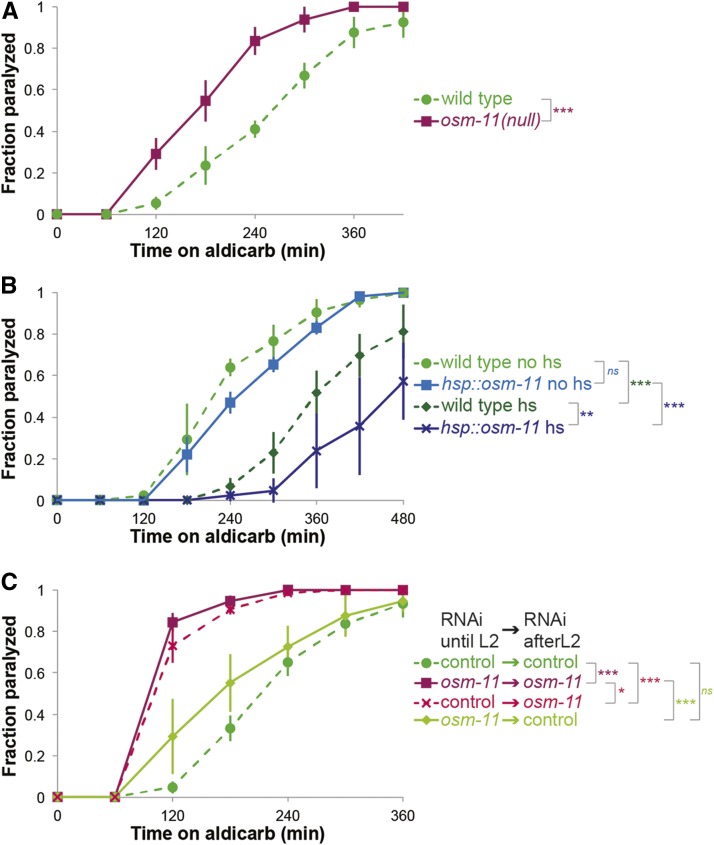
Altering OSM-11 DOS co-ligand levels affect the paralysis rate on aldicarb. (A) Response of osm-11(rt142null) animals to aldicarb. Animals that lack the DOS co-ligand OSM-11 are hypersensitive to aldicarb, similar to lin-12(null) animals. (B) Overexpression of OSM-11 in adults by heat-shock causes resistance to aldicarb compared to heat-shocked wild type controls. (C) osm-11 knockdown by feeding RNAi recapitulates aldicarb hypersensitivity seen in osm-11(rt142null) animals. Knockdown of osm-11 starting from late L2 is enough to cause increased hypersensitivity to aldicarb in adults and restoring osm-11 expression after late L2 stage reverses this hypersensitivity. (hs: heat-shock, no hs: mock heat-shock, at least three independent trials for each experiment, n > 30 for all conditions, error bars represent SEM *: log-rank p-value < 0.05, **: log-rank p-value < 0.01, ***: log-rank p-value < 0.001, ns: no significant difference.)